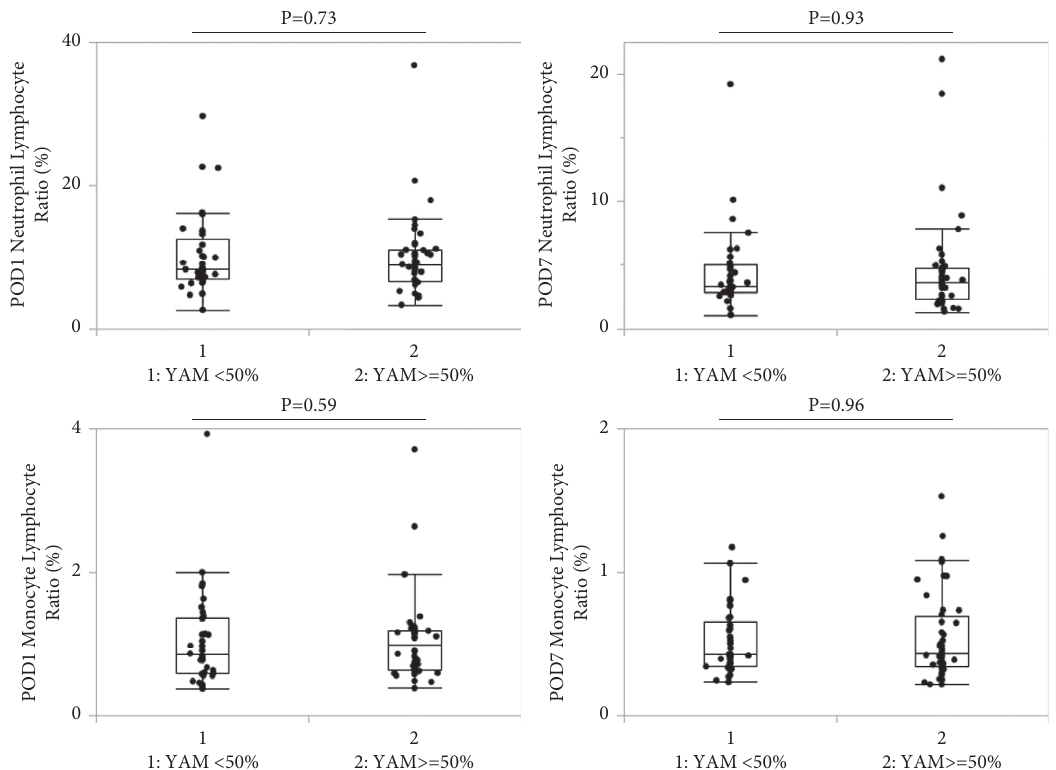
Figure 2: Comparison of neutrophil lymphocyte ratio (NLR) and monocyte lymphocyte ratio (MLR) according to a young adult mean (YAM) cutoff of 50%. On postoperative day (POD) 1 and POD 7, there was no difference for both NLR and MLR between patients with YAM > 50% or YAM <